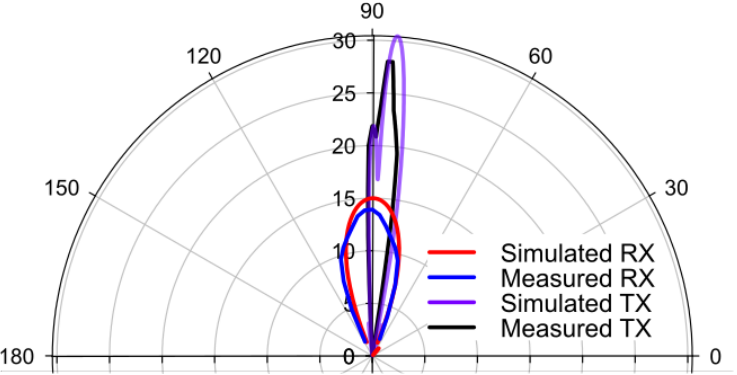
Figure 9. The CST generated and measured gains of the TX antenna 1 and RX antenna for φ =